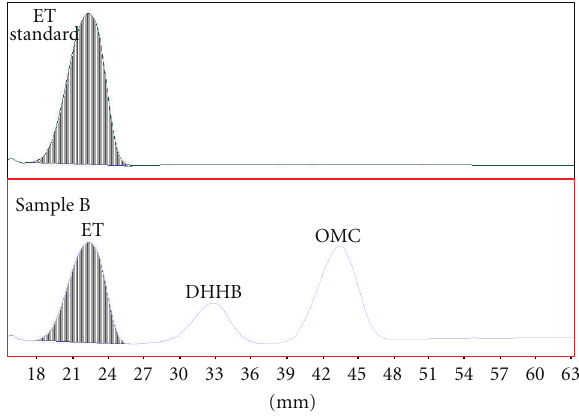
Figure 5: UV spectra of ET isolated from Sample A (1, 2, 3) and of ET standard